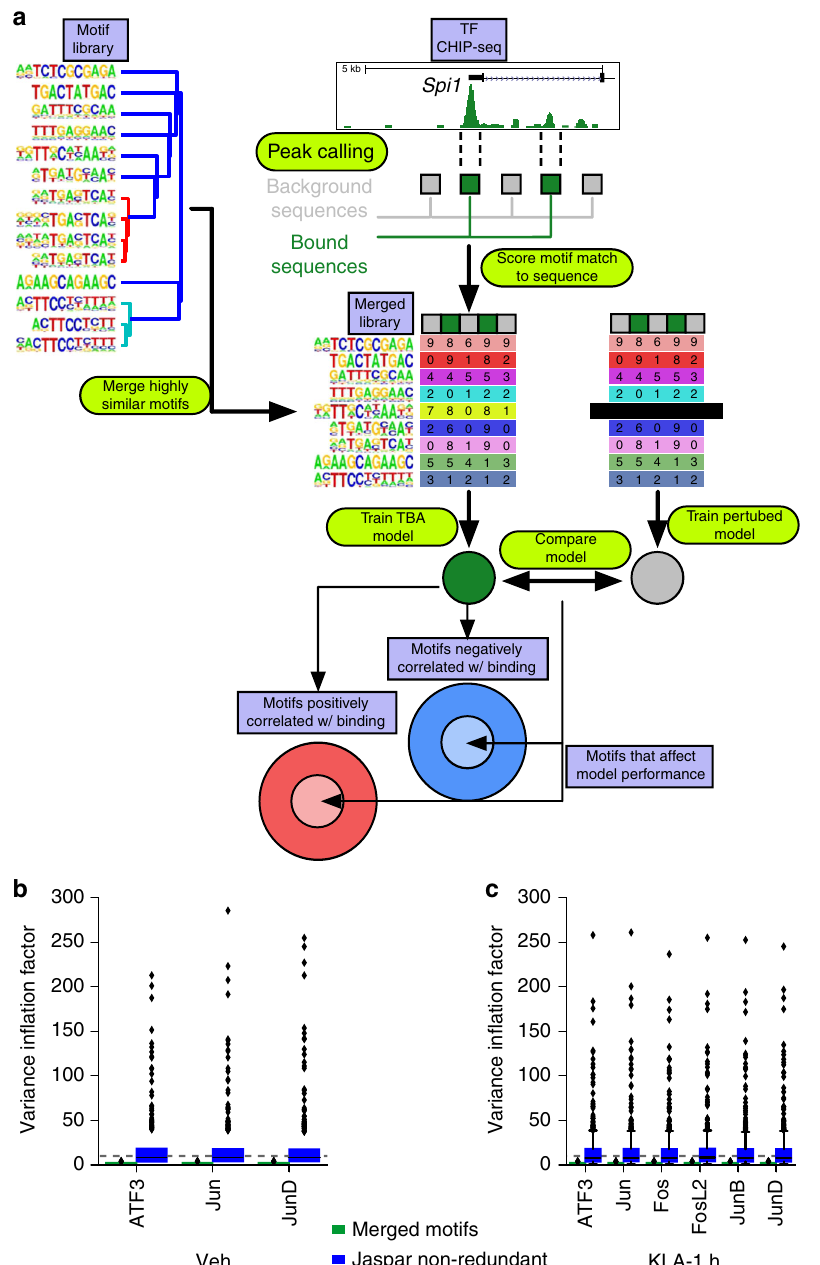
Fig. 3 TBA, a transcription factor binding analysis. a Schematic work fl ow of TBA. Binding sites for a transcription factor (green boxes) are mixed with random GC-matched background sequences (gray boxes). Motifs from the JASPAR library are merged to create a non-redundant motif library. Motif scores are calculated for all sequences at all binding sites and GC-matched background and then used to train a TBA model. Model weights from the trained model indicate whether a motif is positively or negatively correlated with the occupancy of a transcription factor. The performance of the full model and a perturbed model with one motif removed are compared to identify motifs that are important to the model. The intersection of important motifs that affect model performance and the model weights learned by the classi fi er can be used to infer the binding partners of a transcription factor. b , c Distribution of variance in fl ation factor for each motif in the TBA merged motif library and JASPAR motif library for experiments performed in b Vehicle and c Kdo2 lipid A treated thioglycollate elicited